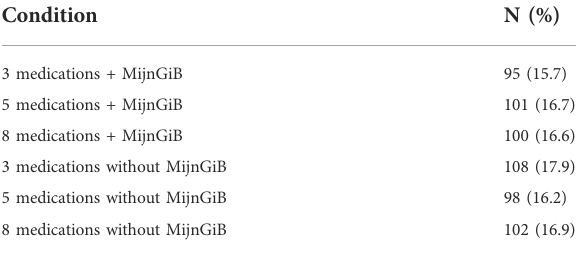
TABLE 1 Distribution of participants per